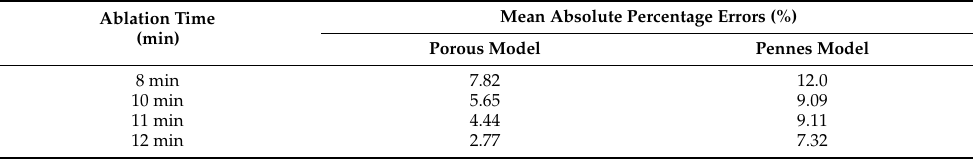
Table 4. Mean absolute percentage errors between simulation and experimental